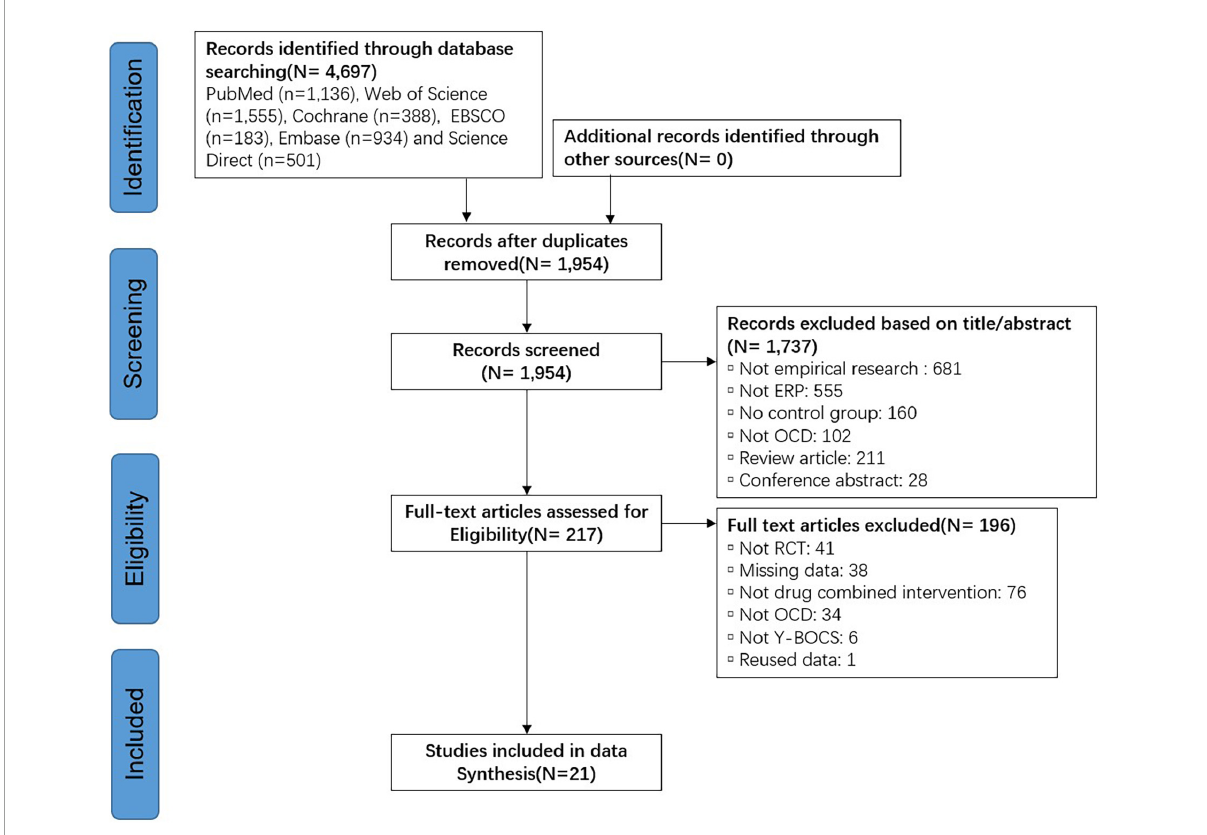
FIGURE1 PRISMA flow diagram of article inclusions and exclusions.